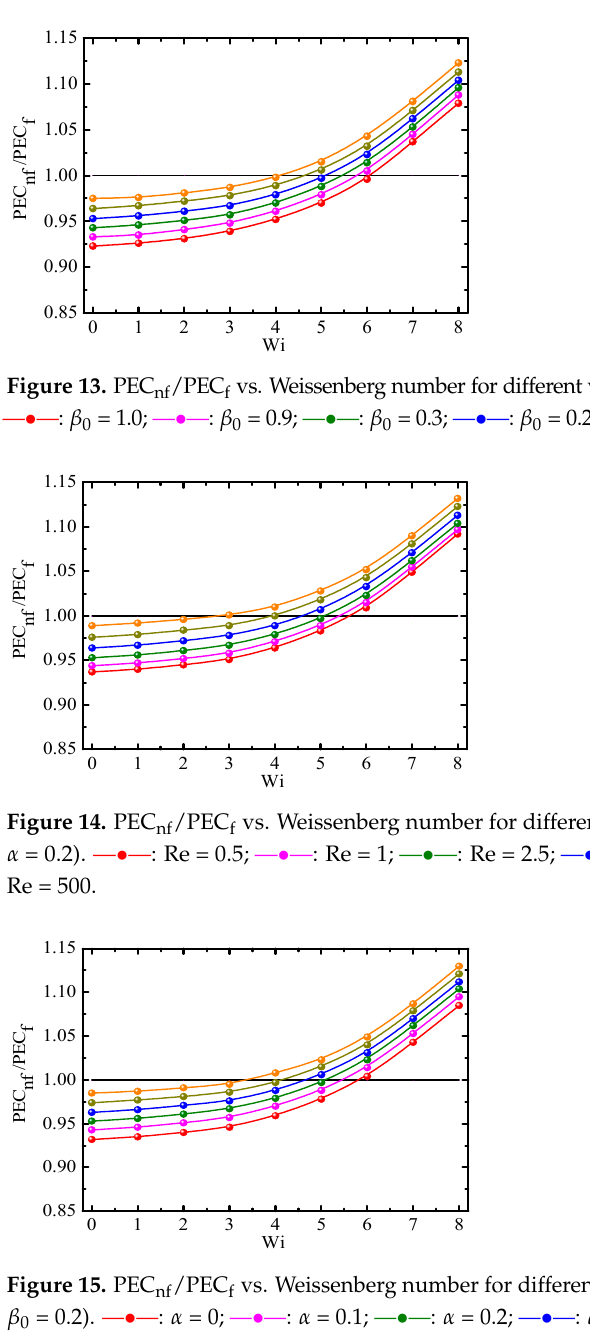
Figure 12. PEC nf /PEC f vs. Weissenberg number for different particle concentrations ( β 0 = 0.2, Re = 2.5, α = 0.2). ⸺ ● ⸺ : Φ = 0% (Giesekus fluid); ⸺ ● ⸺ : Φ =0.5% (Giesekus fluid); ⸺ ● ⸺ : Φ = 1.0%; ⸺ ● ⸺ : Φ = 2.0%; and ⸺ ● ⸺ : Φ = 3.0%.